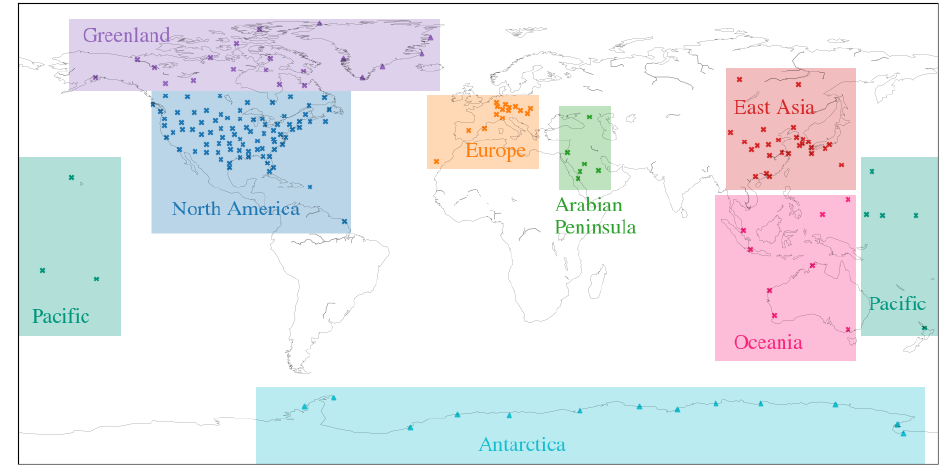
Figure 6. Locations of the ARSA stations with at least 300 observations per year (crosses) and the stations in two other regions (Greenland and Antarctica) that do not satisfy this condition are marked with triangles. The rectangles of colour correspond to the regions in which we compared IASI temperatures to